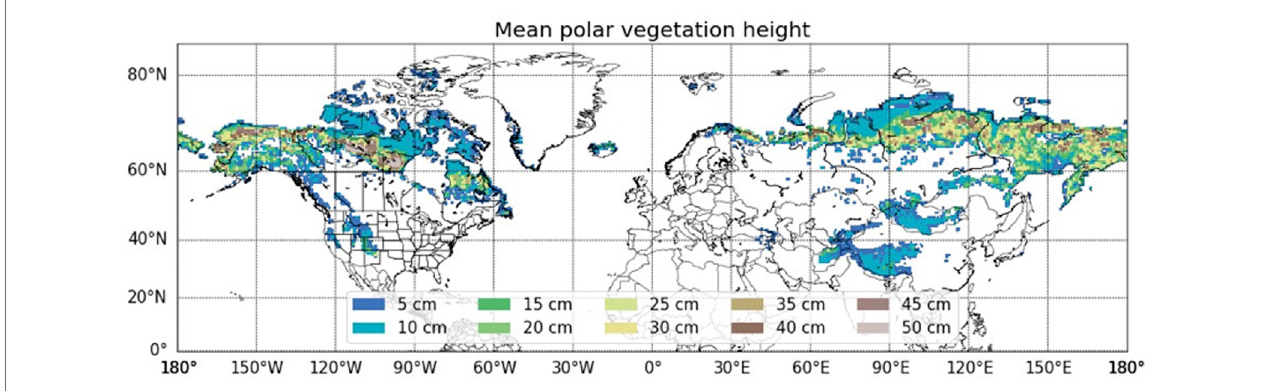
FIGURE 2 | Vegetation height prescribed as input for Crocus